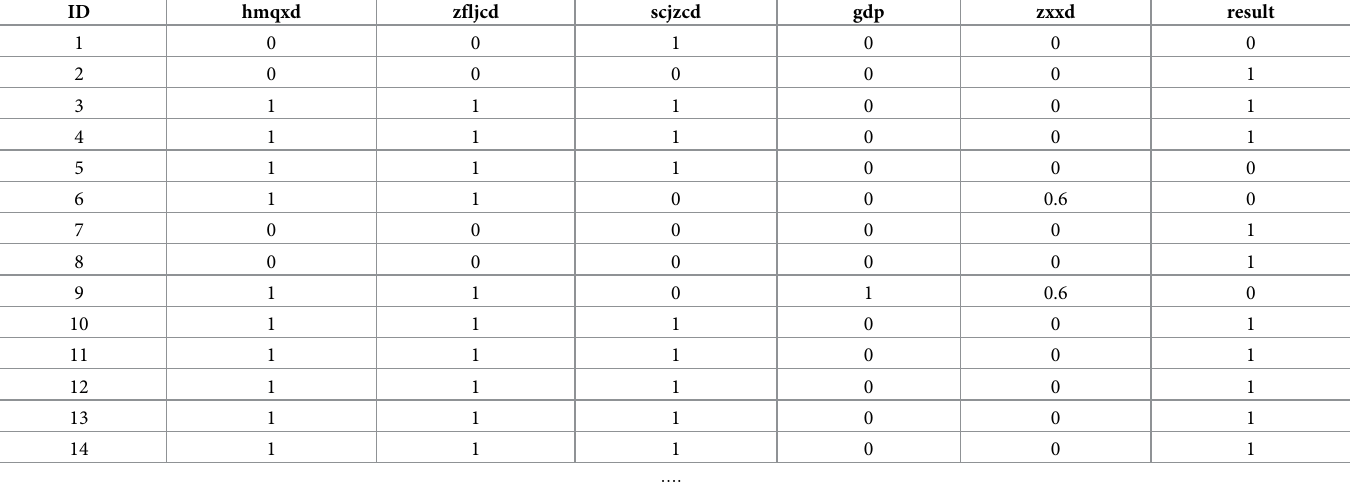
Table 5. Calibrated vertical collusion control truth table